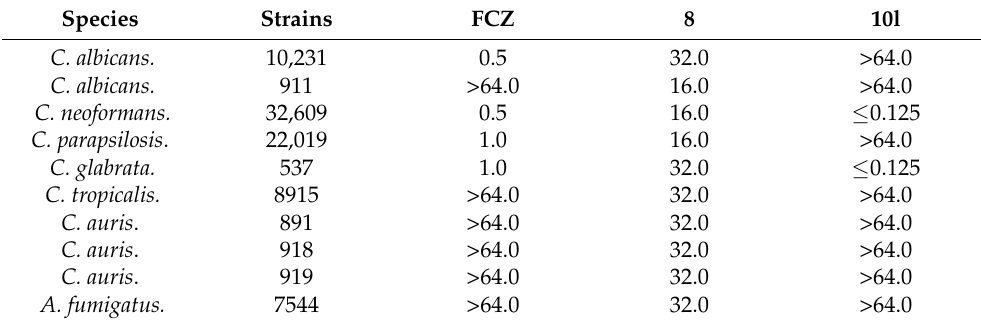
Table 3. Antifungal spectrum of compound 10l (MIC 80 , μg/mL, 48 h). Species